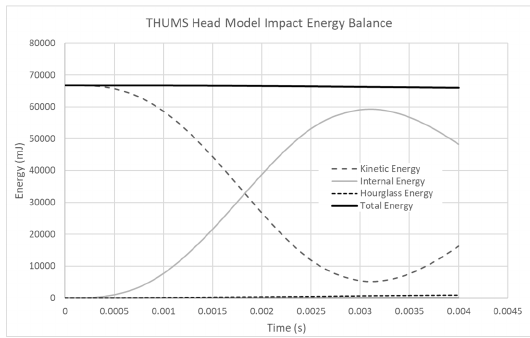
Figure 3. Typical Energy balance in a THUMS head model under impact.